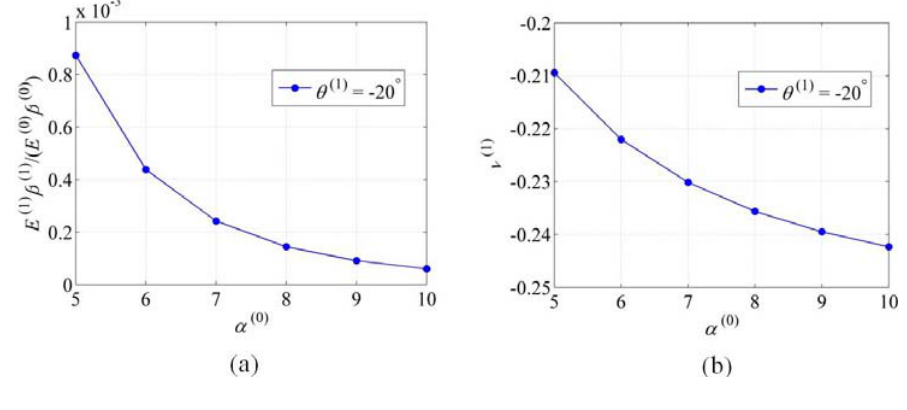
Figure 4. Schematics of ( a ) vs. vs.